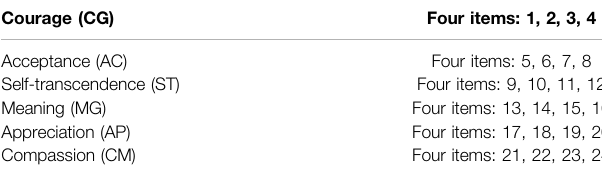
TABLE 2 | The coding key of the CasMac Measure of Character. Courage (CG)